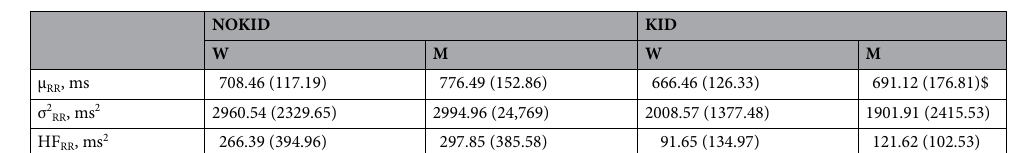
Table 5. Results of the cardiac autonomic profile comparison between working women and men in relation to the presence of preschoolers during DAY. DAY, daytime; KID, children in preschool age; NOKID, no children in preschool age; W, women; M, men; RR, RR interval; μ RR , mean RR; σ 2 RR , variance of RR; HF, high frequency; HF RR , power of RR series in the HF band. Results are presented as median. In bracket the interquartile range, calculated as the difference between the first and the third quartile is presented. $ indicates p < 0.05 KID versus NOKID.